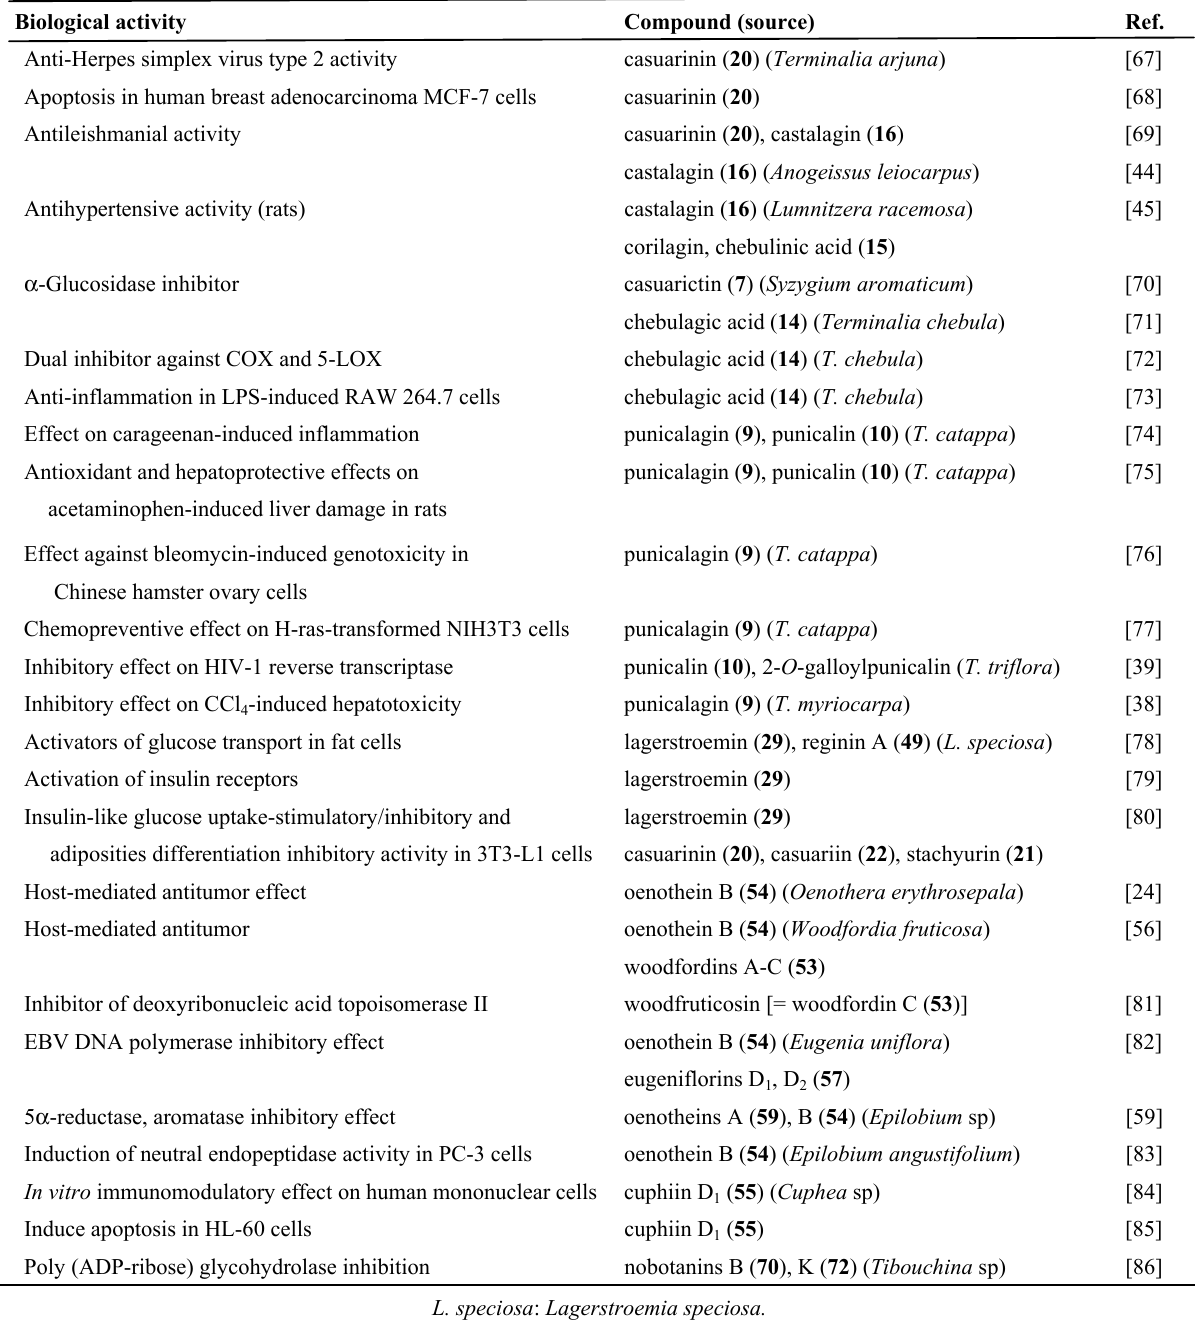
Table 3. Biological activities of ellagitannins found in the